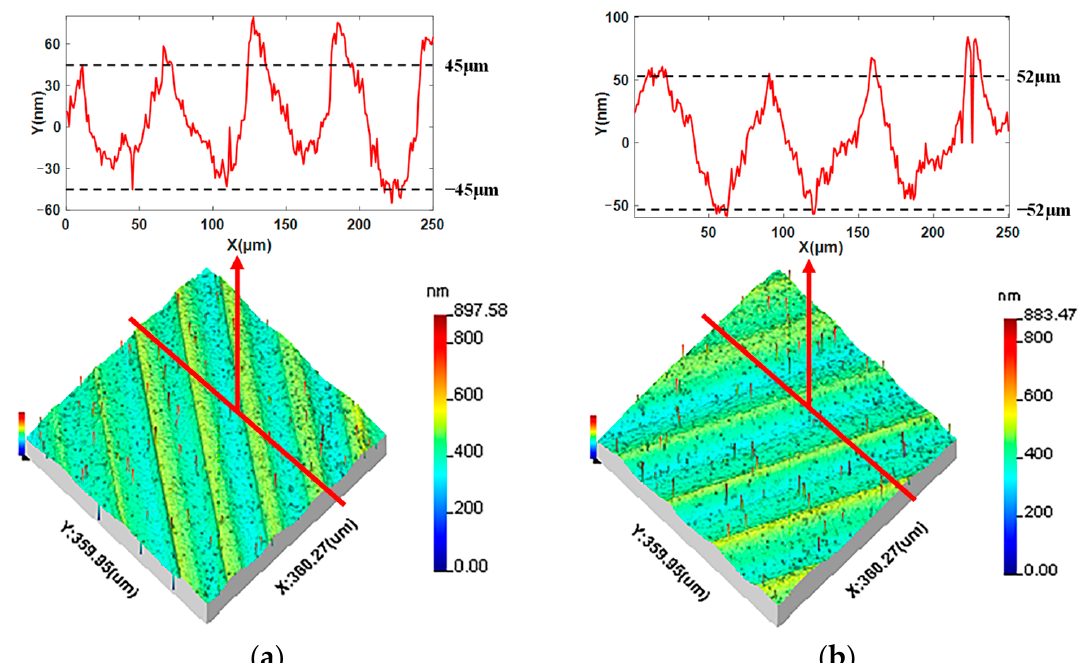
Figure 2. Experimental 3D surface topographies and 2D profiles: ( a ) experiment surface with a p = 6 μ m, n = 1300 r/min, f = 12 μ m/r; ( b ) experiment surface with a p = 9 μ m, n = 1400 r/min, f = 14 μ m/r. Table 2. Cutting parameters used in the experiments. Table 3. Mechanical parameters of the KDP